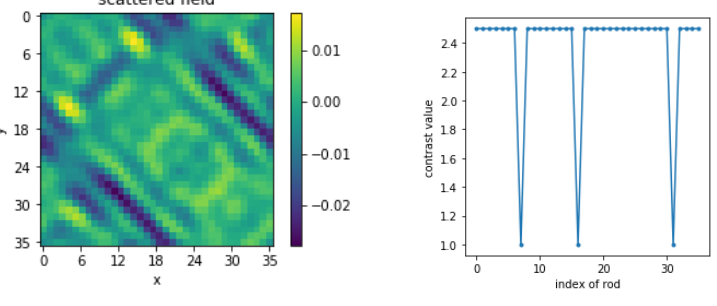
Figure 10. Example of the dataset.